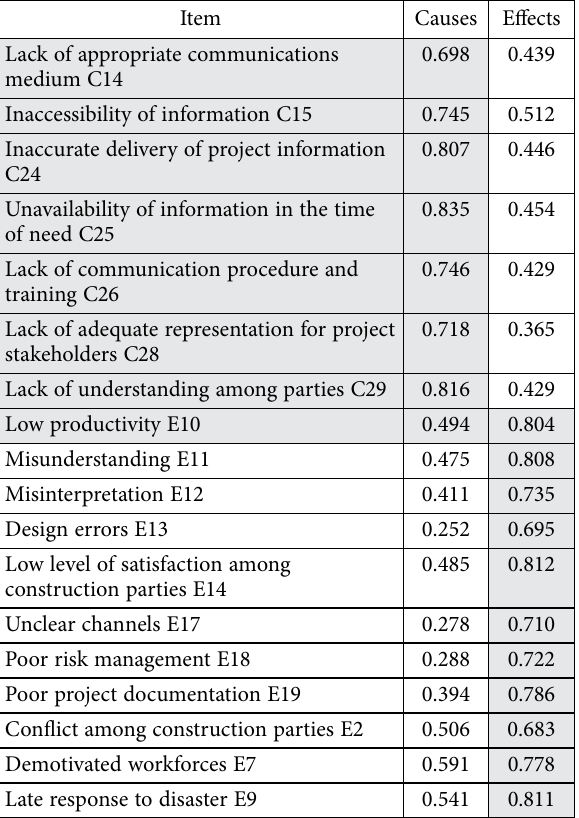
Table 7. Discriminant validity-cross loading of items